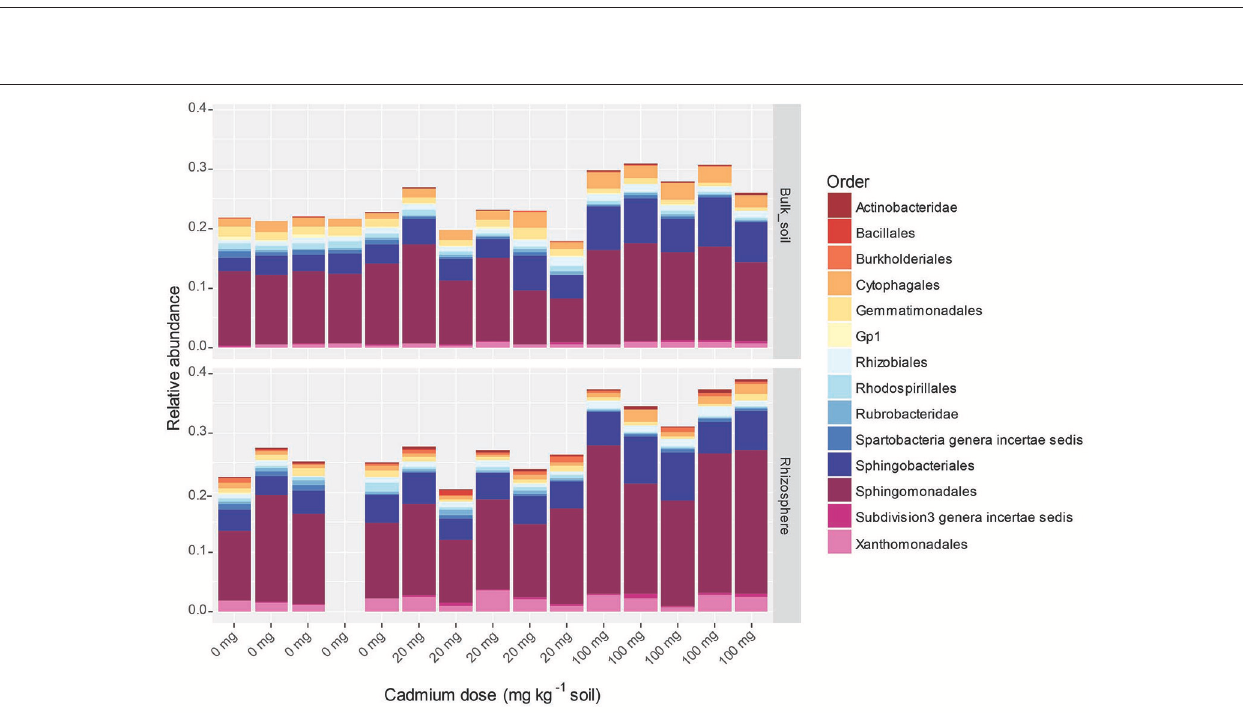
FIGURE 5 | Relative abundance of OTUs found to respond significantly ( p < 0.05) to Cd dose in the rhizosphere and bulk soils. OTUs are clustered by order. Only orders that represented > 0.5% of the total community are represented. Absent bar represents replicate that was excluded due to under sampling. Orders denoted as Gp “X” are groups belonging to the phylum